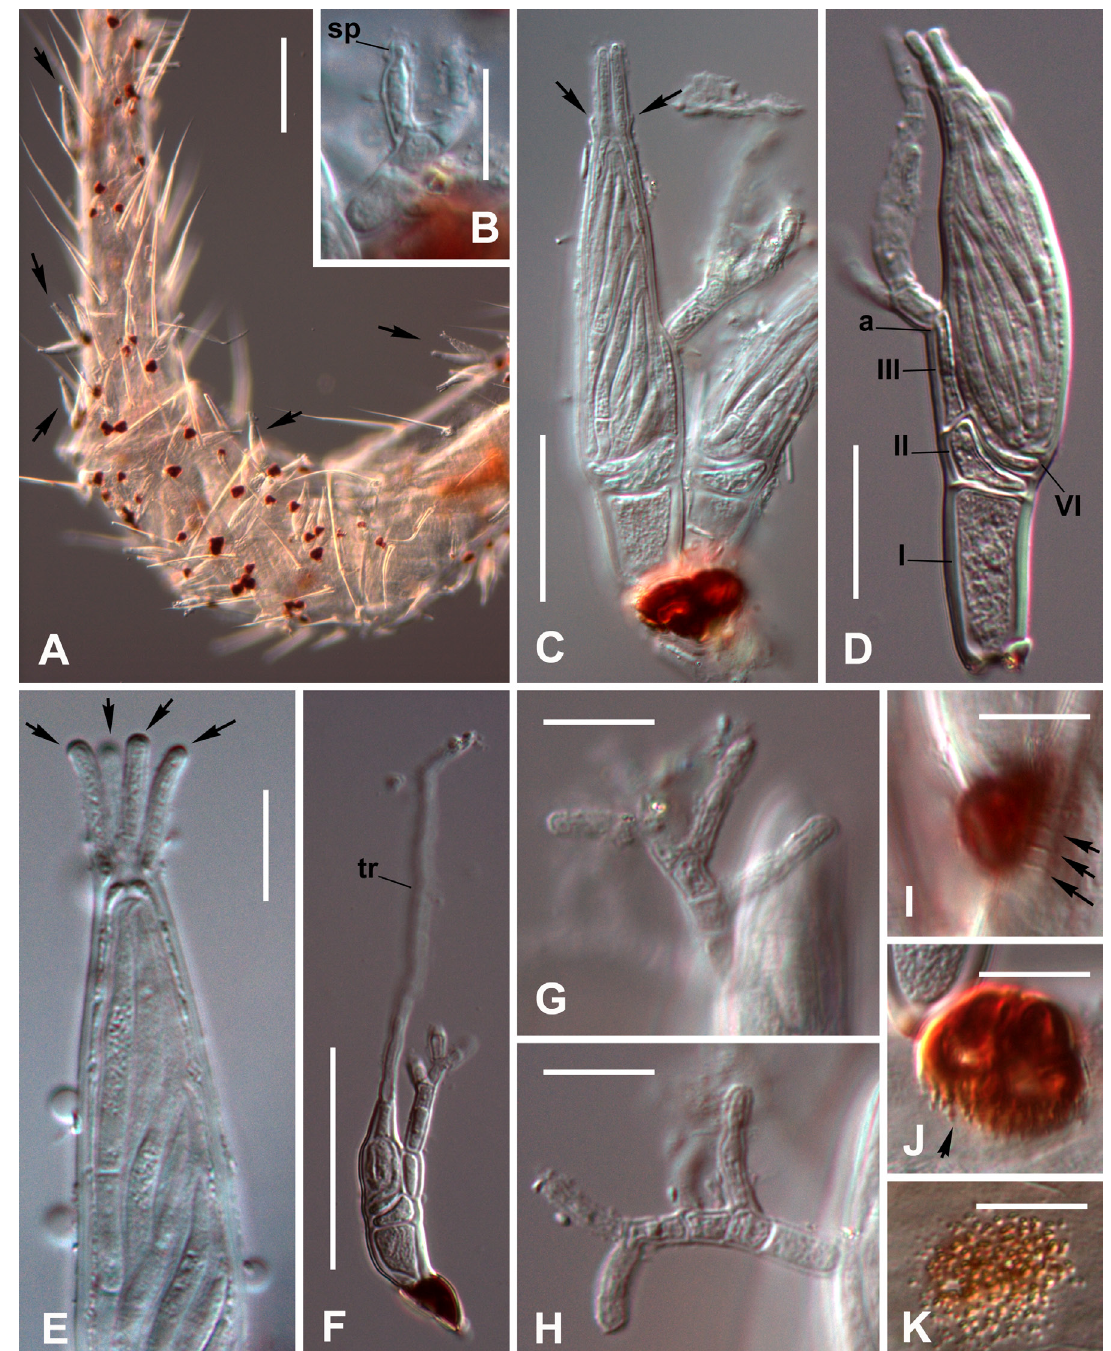
Fig. 5. Troglomyces tetralabiatus Santam., Enghoff & Reboleira sp. nov. A . Leg covered with thalli (see arrows for thalli, dark dots are blackened feet). B . Antheridium with spermatium. C . Mature thallus, with focus on scars near perithecial apex (arrows). D . Mature thallus with labelling of cells and other elements. E . Detail of perithecial apex showing the four conspicuous lips. F . Immature thallus with trichogyne (tr). G – H . Detail of well-developed primary appendages. I – K . Details of feet with digitations in side view (I–J) and in front view (K). Scale bars 100 µm (A), 50 µm (F), 25 µm (C–D), and 10 µm (B, E, G–K). Photographs from: slides SS E614a (A), SS E615b (B), SS E584c (C), SS E613f (D), SS E613b (E), C-F-92270 (F) and SS E584b